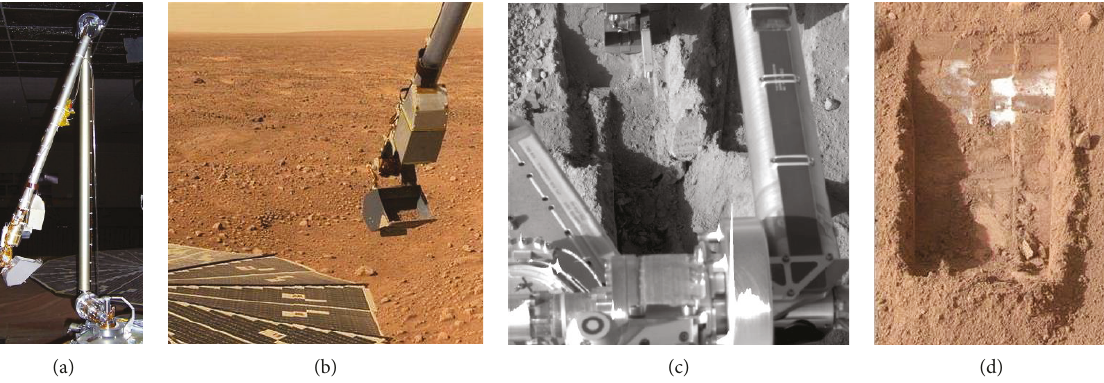
Figure 9: Phoenix Mars Lander Robotic Arm and its sampling process.